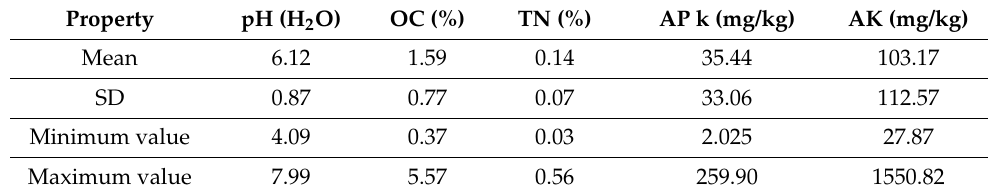
Table 2. Overall means, standard deviations, and ranges of soil properties and nutrients in